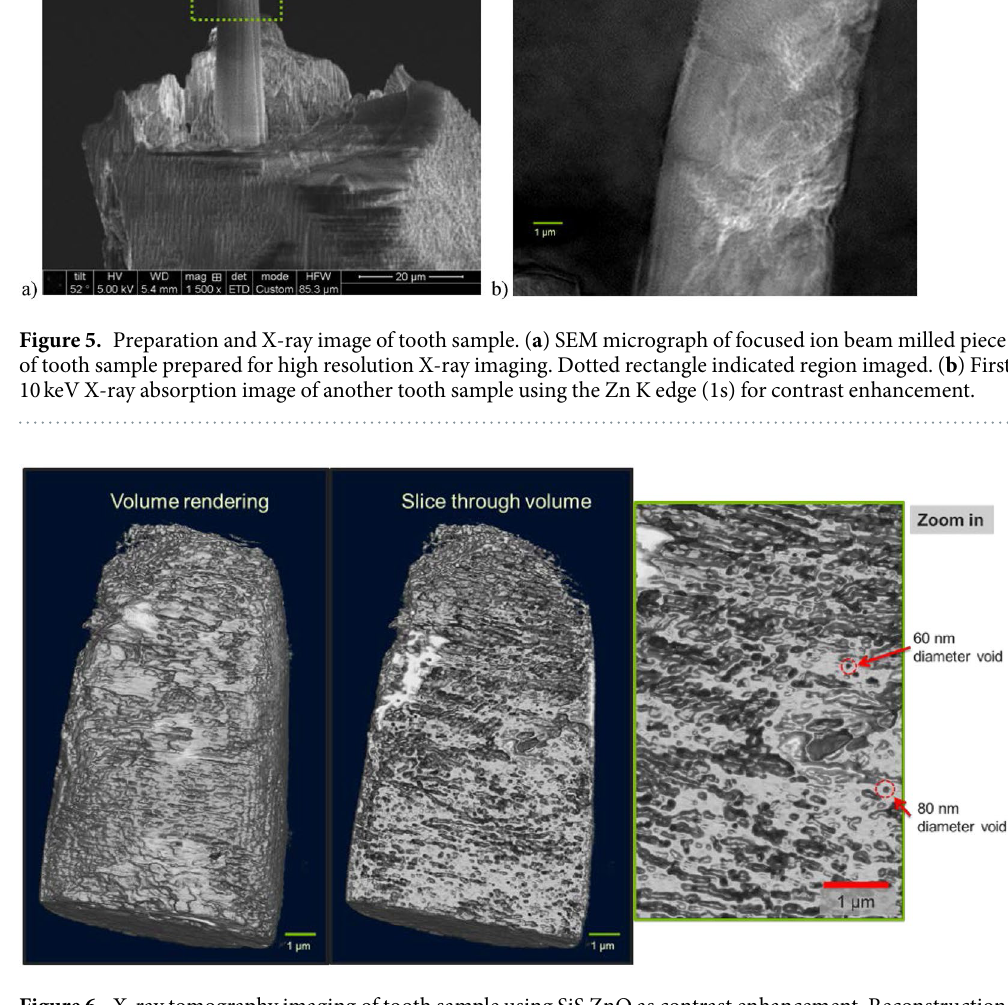
6 Scientific REPORtS | 7: 5879 | DOI:10.1038/s41598-017-05690-6